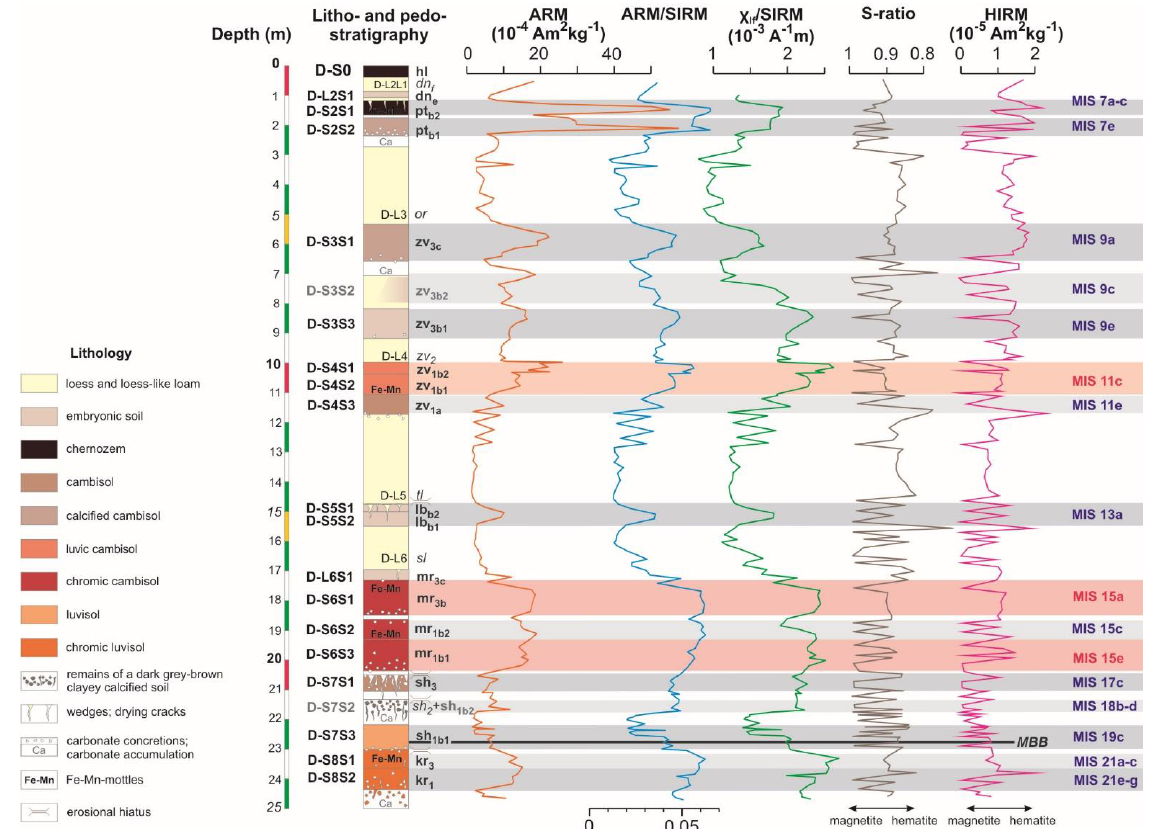
Figure 5. Variations of selected rock magnetic parameters of the Dolynske section (explanation in the text), and their relation to marine isotope stages (MIS).